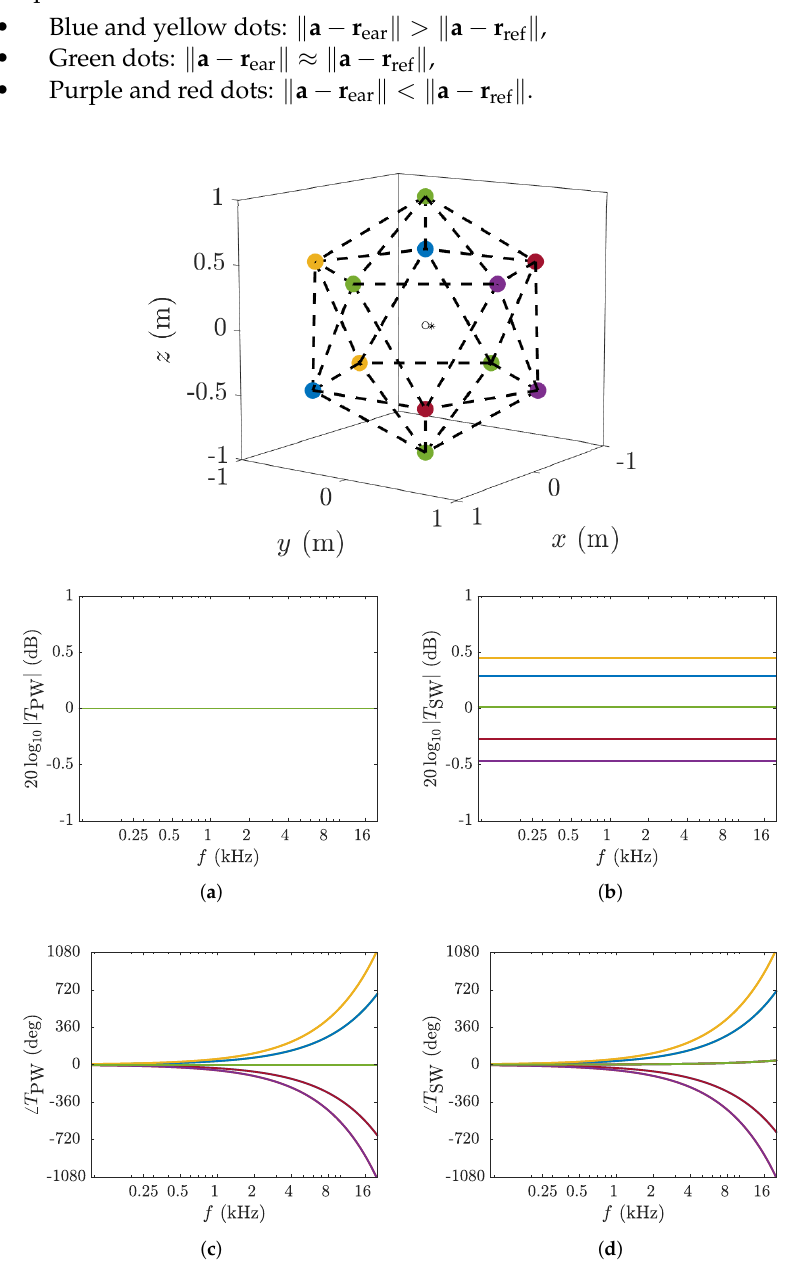
Figure 6. PW and SW direct translation operators for twelve different directions along the vertices of the icosahedron (top panel), at a distance of 100 cm from the center of the head. ( a ) Magnitude in (22); ( b ) Magnitude in (24); ( c ) Phase in (23); ( d ) Phase in (25). In Figure 6, panels (a) and (b) show the magnitude of the PW and SW translation operators identified in (22) and (24) respectively, expressed in logarithmic scale from − 1 dB to 1 dB; and panels (c) and (d) show the phase of the PW and SW translation operators identified in (23) and (25), respectively, expressed in degrees from − 1080 to 1080